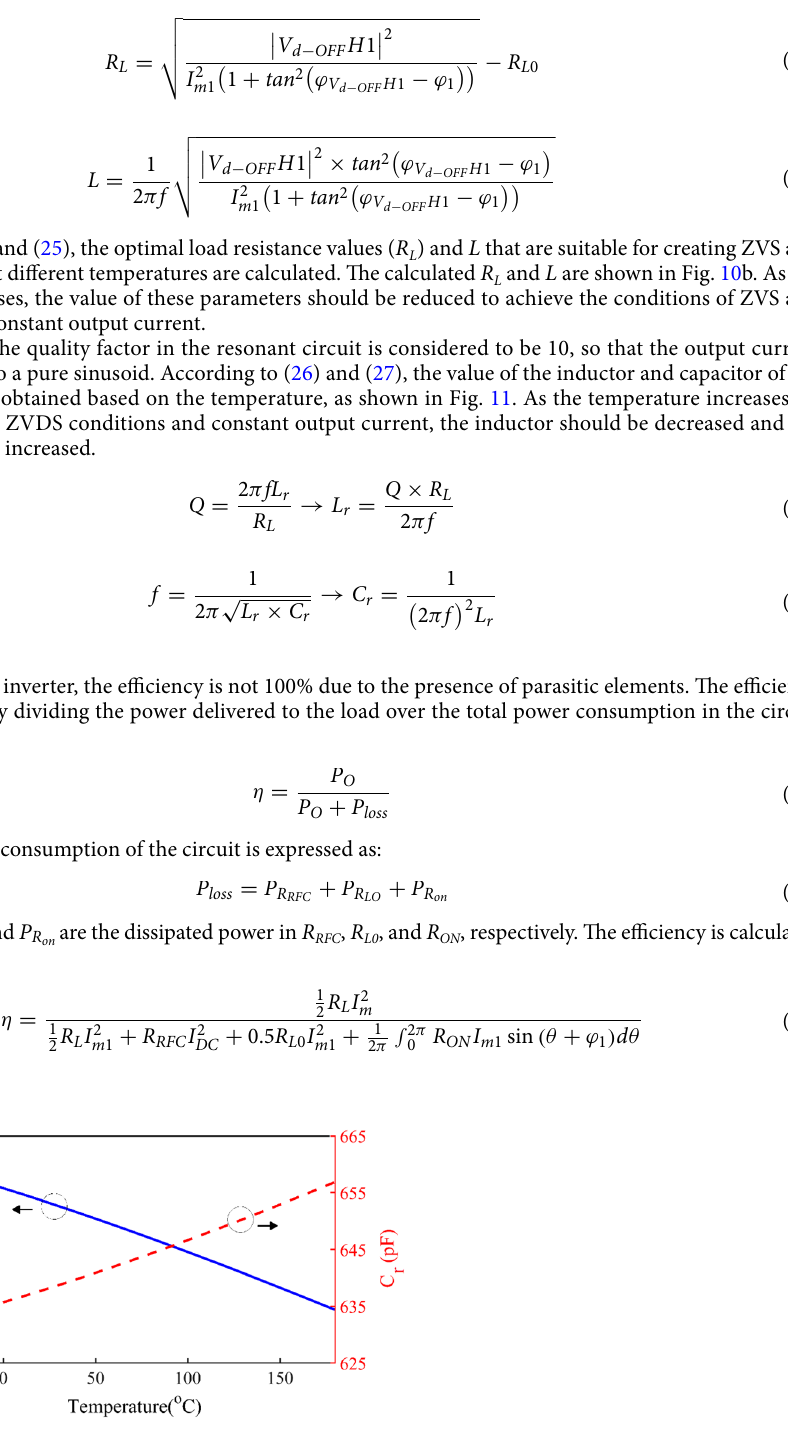
Figure 11. The L r and C r of the series